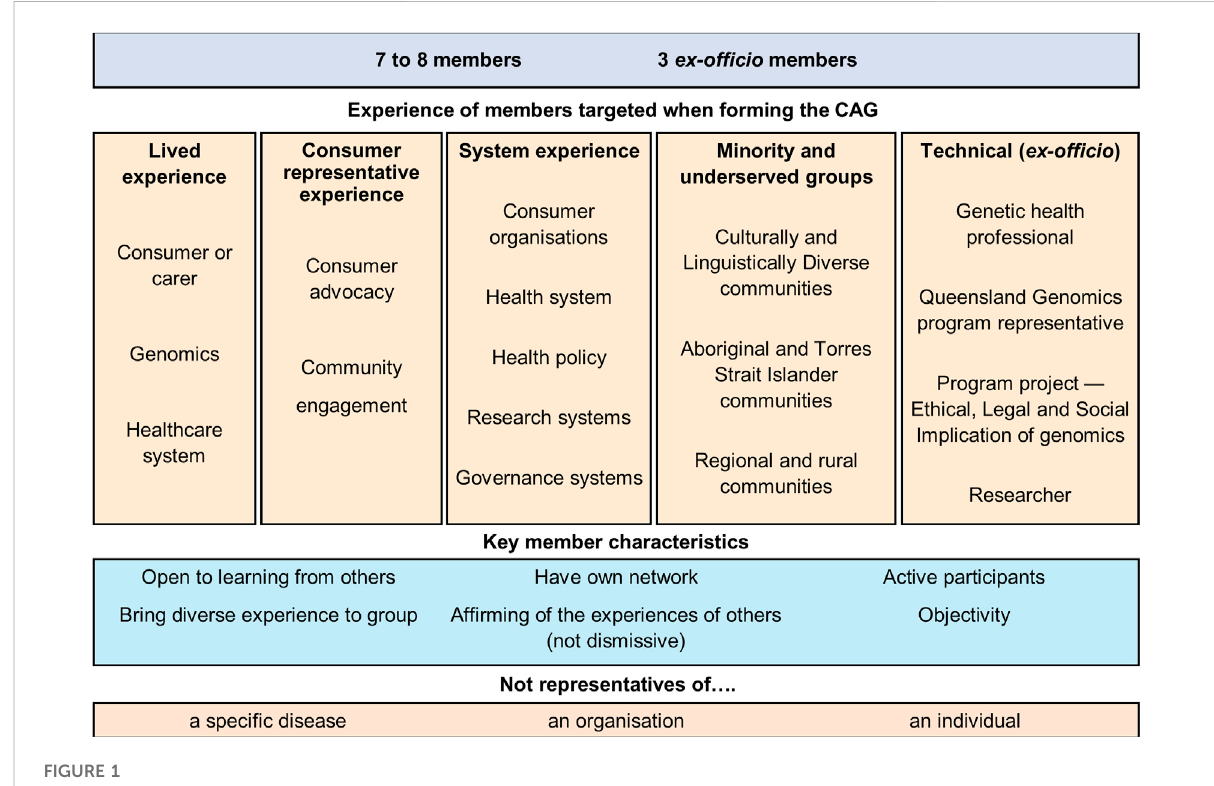
FIGURE 1 Community Advisory Group members ’ characteristics and